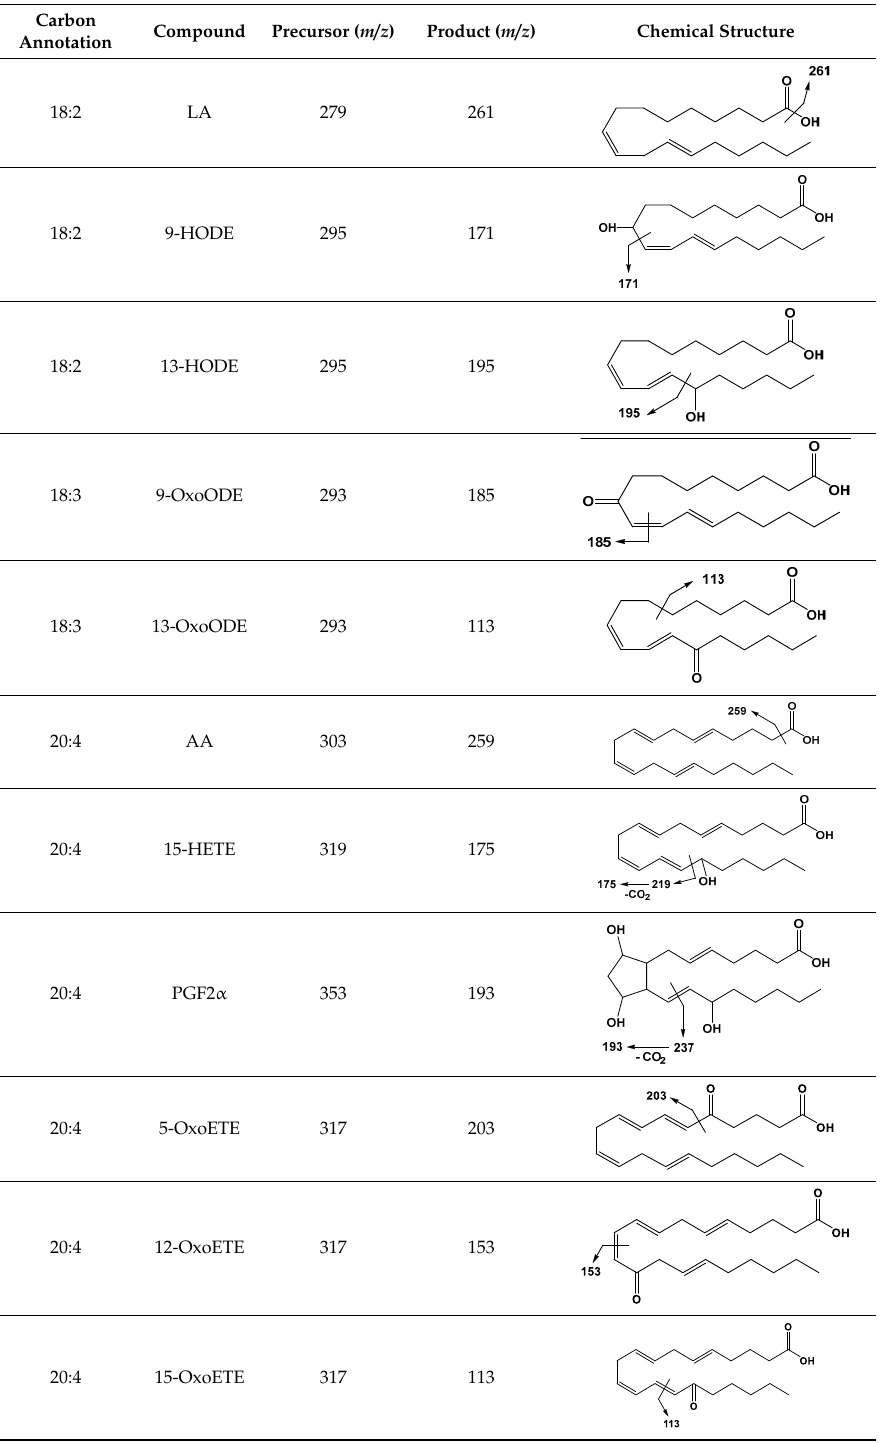
Figure 3. Structural identification of oxidized arachidonic acid by ESI-MS/MS fragmentation pattern. 3.4. Volatile Compound Profile The volatile profile of salted meat is shown in the Table 4 (expressed as UA × 10 4 /g of dry matter). A total of 57 volatile organic compounds (VOC) of 8 different chemical groups were separated and identified in the meat samples. These groups were hydrocarbons (17 compounds), alcohols